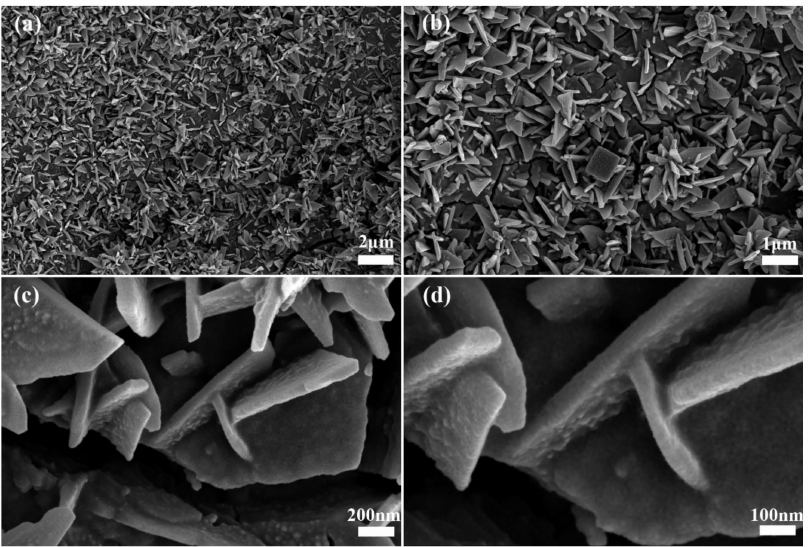
Figure 3. SEM images of ZCM. ( a ) 5 K magnification, ( b ) 10 K magnification, ( c ) 50 K magnification and ( d ) 100 K